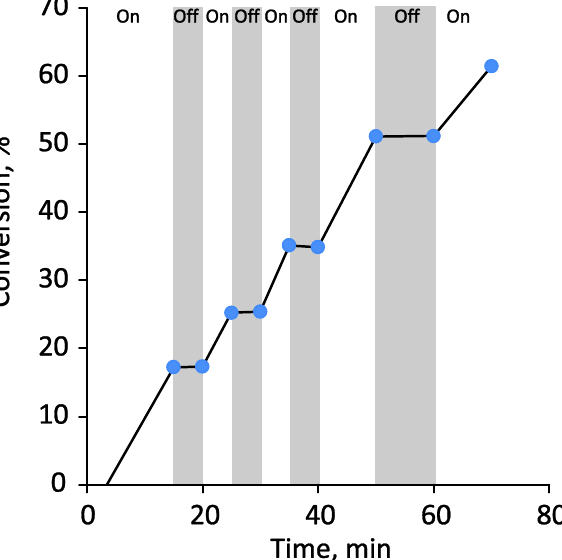
Figure 6. “On/off” experiment for the photo-induced RAFT polymerization of MPEGMA in DMSO. Polymerization conditions: ω MPEGMA = 50 wt.%, [MPEGMA] 0 /[CDTPA] 0 = 200:1, blue LED, 7 mW/cm 2 , 35 °C.